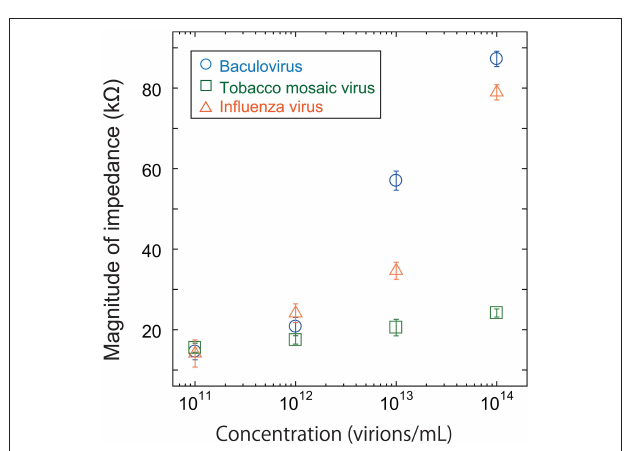
FIGURE 5 | Magnitude of impedance for baculovirus, TMV, and influenza virus solution at 1 MHz. The concentration was varied from 10 11 to 10 14